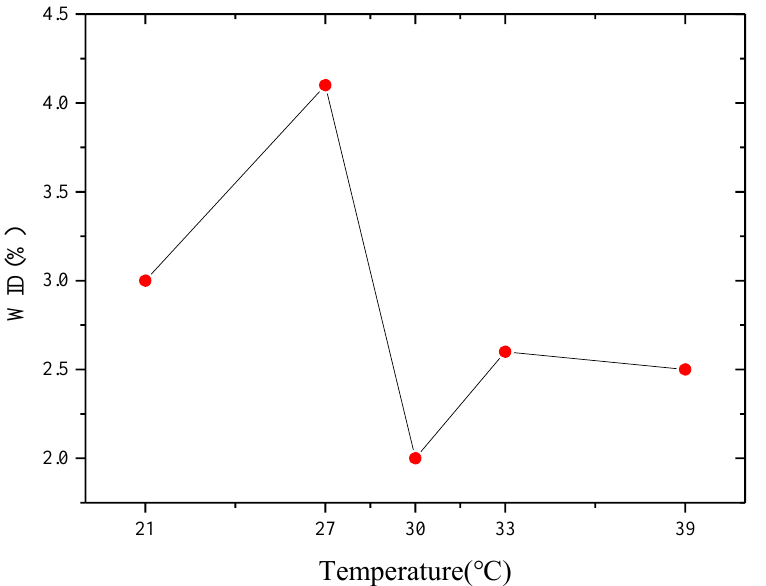
Figure 4. Height deviation of bump according to temperature variation, WID. Table 4. Condition and measurement of Sn microbumps by temperature